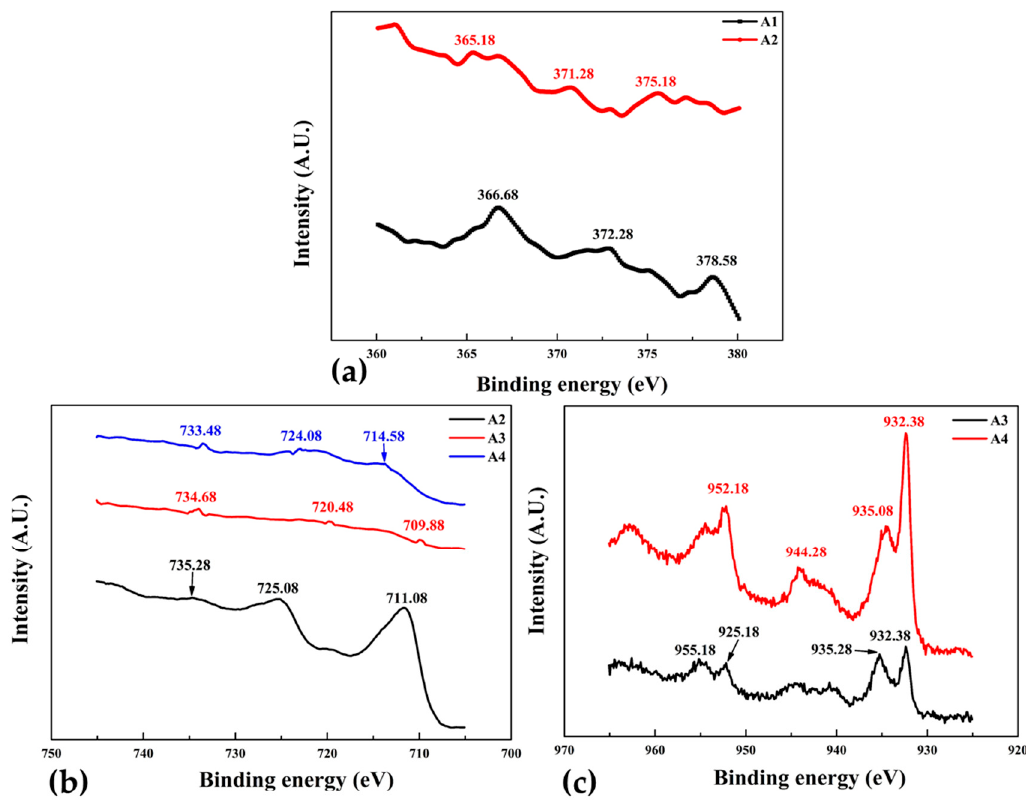
Figure 10. X-ray photoelectron spectra of group 1 thin films ( a ) Ag 3 d; ( b ) Fe 2 P; and ( c ) Cu 2 P.